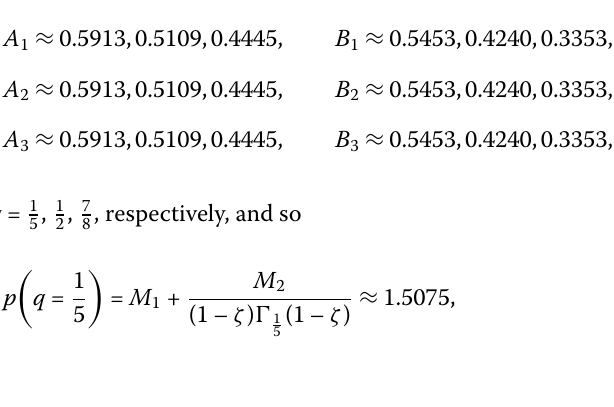
, 1 , 7 in Example 5 2 8